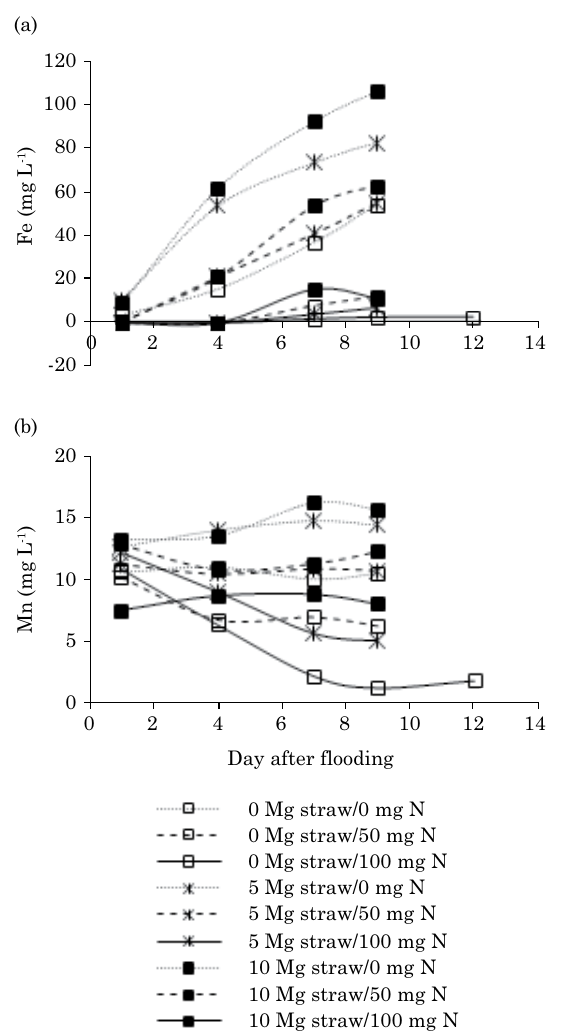
Figure 5. Levels of Fe (a) and Mn (b) in flooded soil solution under different amounts of rice straw and rates of NO − 3